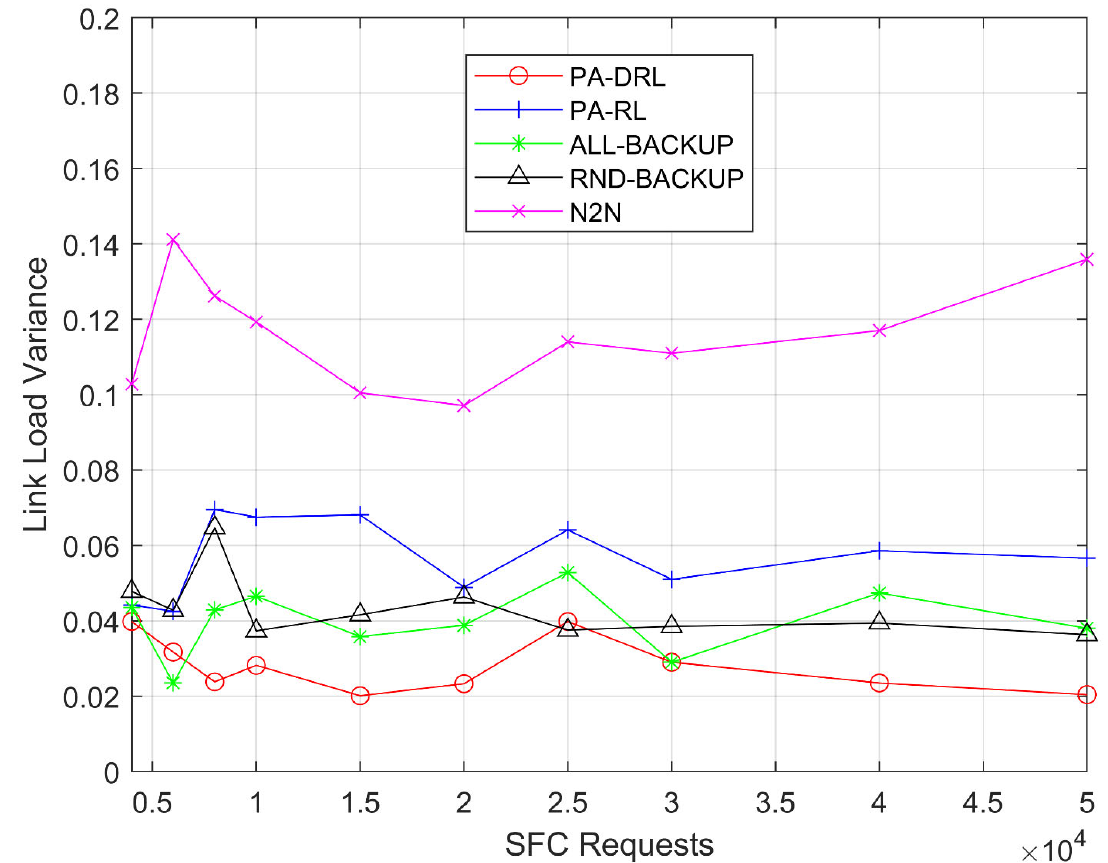
Figure 8. Link load balancing variance under each SFC requests number.